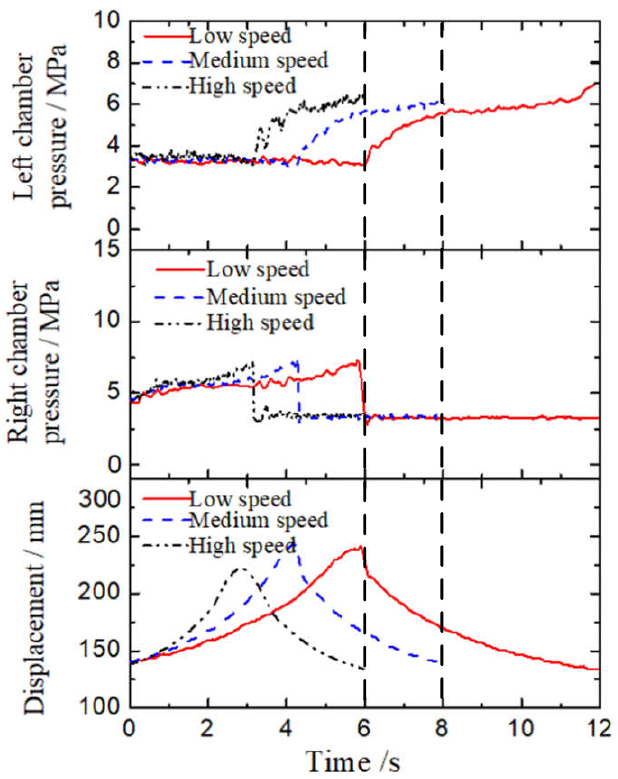
Figure 13. Test curves with different steering speeds under normal load conditions.